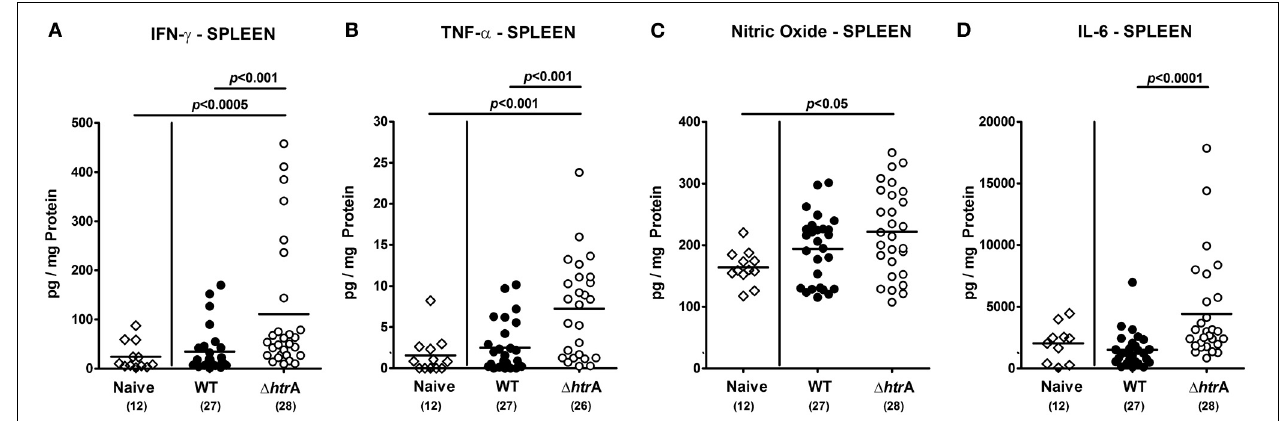
FIGURE 6 | Pro-inflammatory cytokine responses in spleens following C. jejuni infection of gnotobiotic IL-10 − / − mice. Splenic (A) IFN- γ , (B) TNF- α , (C) nitricoxide,and (D) IL-6levelsweredeterminedinsupernatantsof exvivo biopsiestakenatday6p.i.Datashownwerepooledfromfiveindependentexperiments.